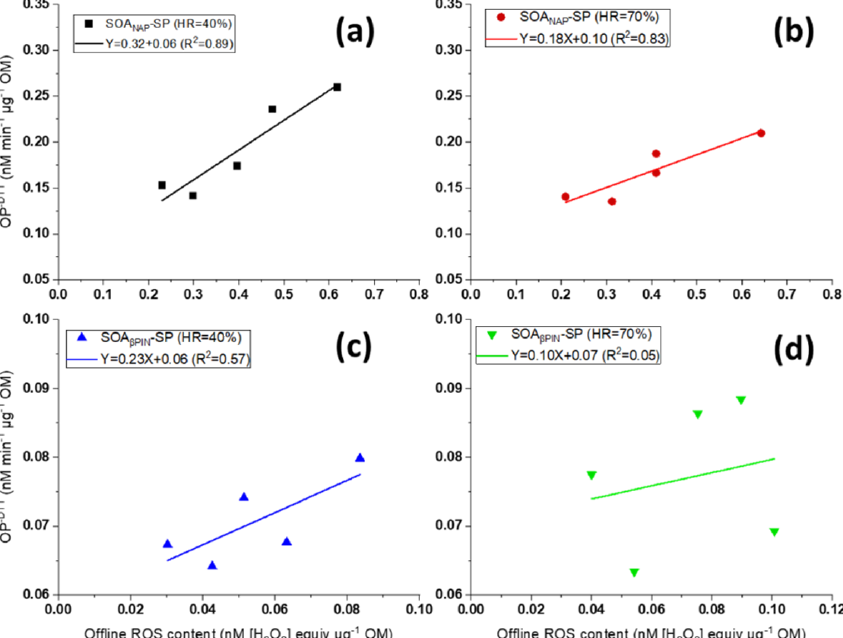
Figure 7. Correlation between offline ROS content and the (offline) oxidative potential (OP) of particles (the data points from left to right correspond to 2, 3, 4, 5 and 9d photochemical aging) for SOA NAP -SP at 40% and 70% relative humidity, (a) and (b) , respectively, and for SOA β PIN -SP at 40% and 70% relative humidity, (c) and (d) , respectively. OP and offline ROS of SOA NAP -SP are clearly positively correlated, while there is a weaker correlation between OP and offline ROS of SOA β PIN